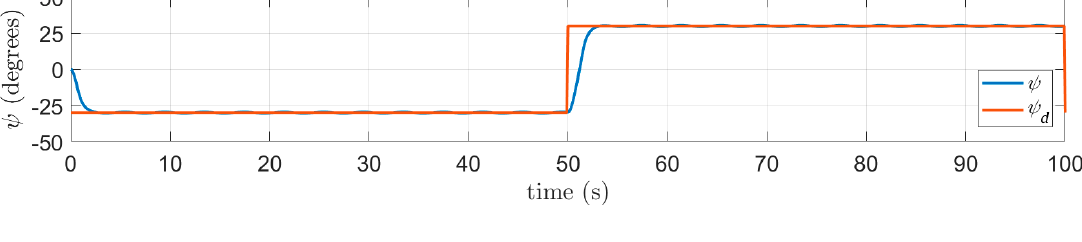
Figure 11. Simulation results of parameter adaptation without robust action.